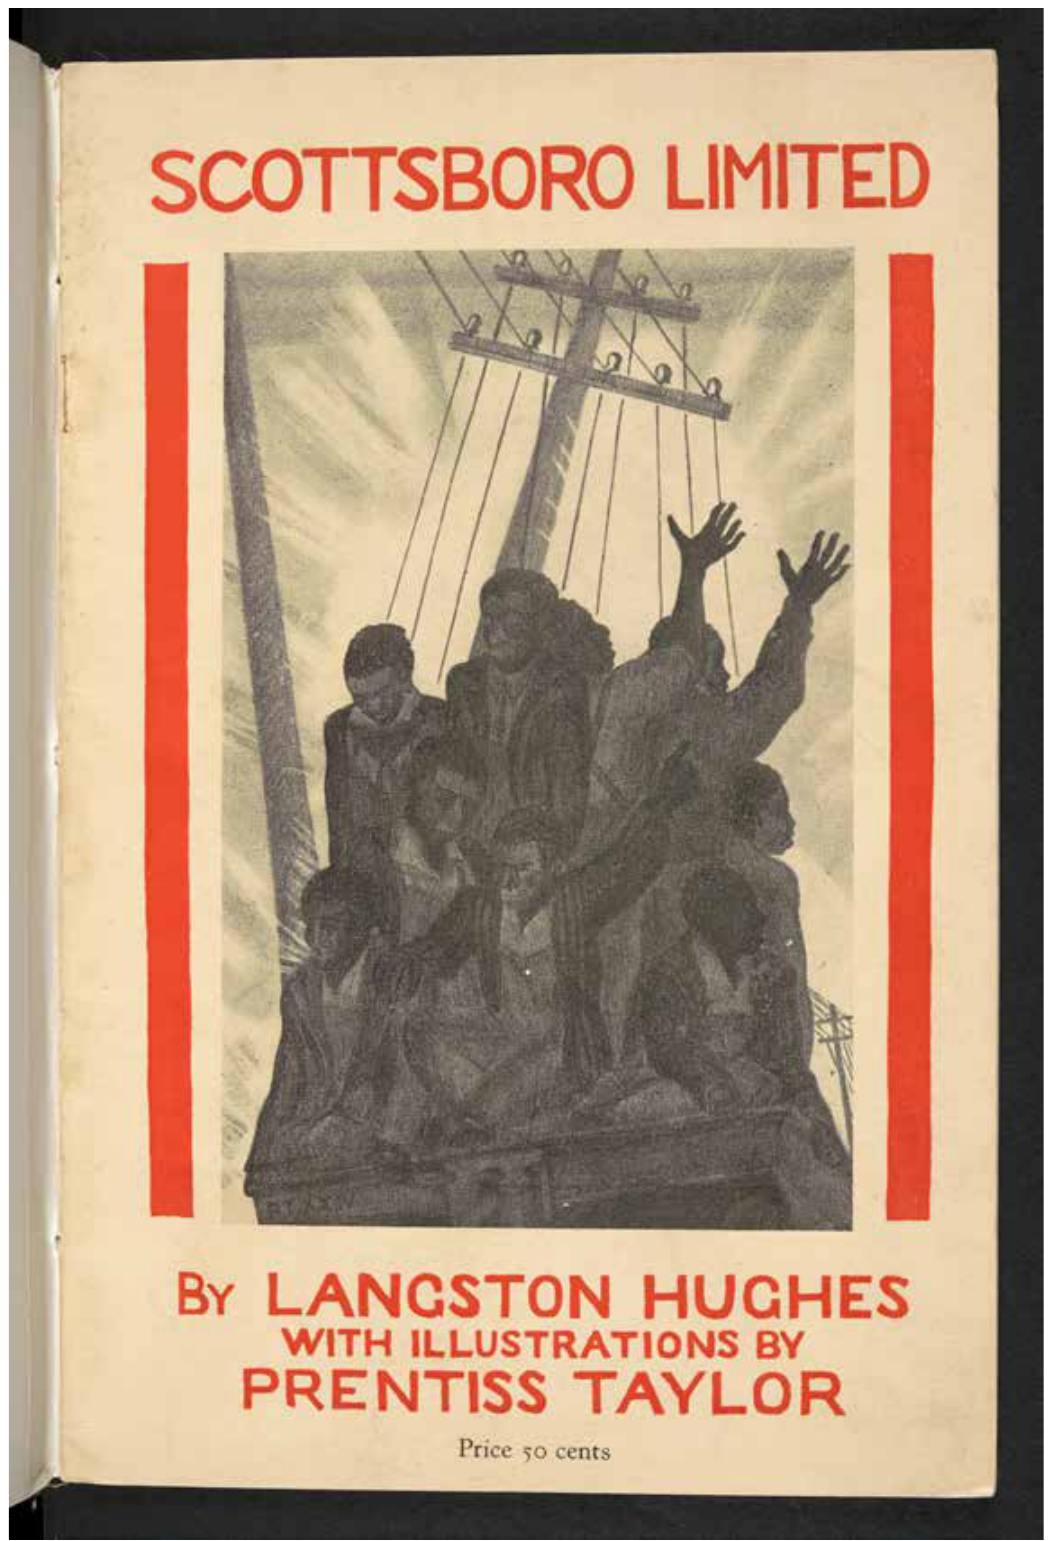
Fig. 1. Langston Hughes, Scottsboro Limited (New York: Golden Stair Press, 1932). BL,